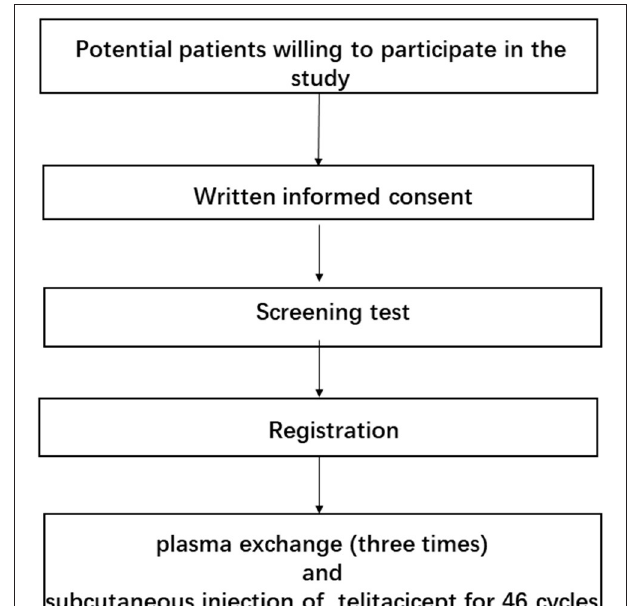
FIGURE 1 | Summary of the